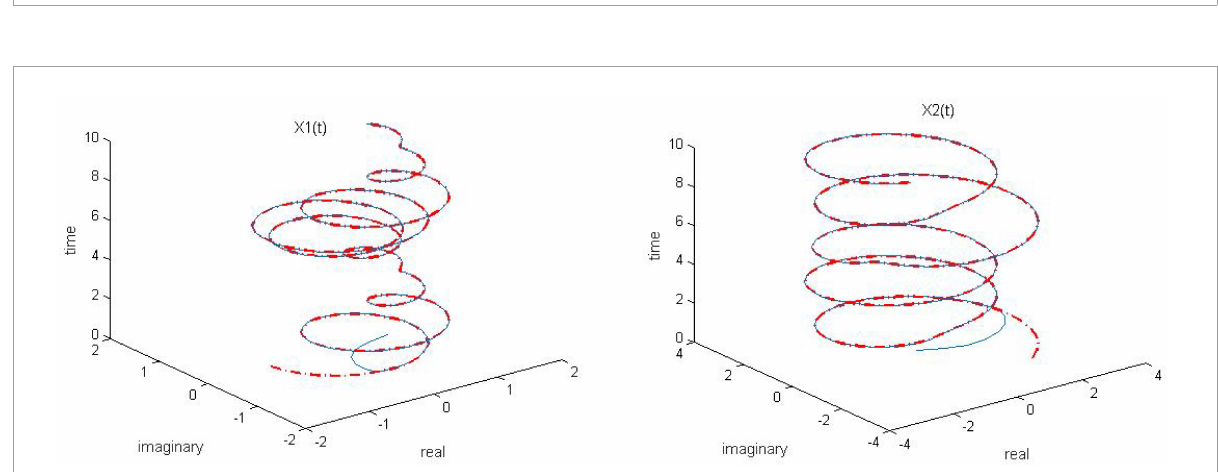
FIGURE2 Dynamic complex matrix equation (DCME) (1) solved by robust zeroing neural network (RZNN) model (10) with k = 1 in no noise environment.